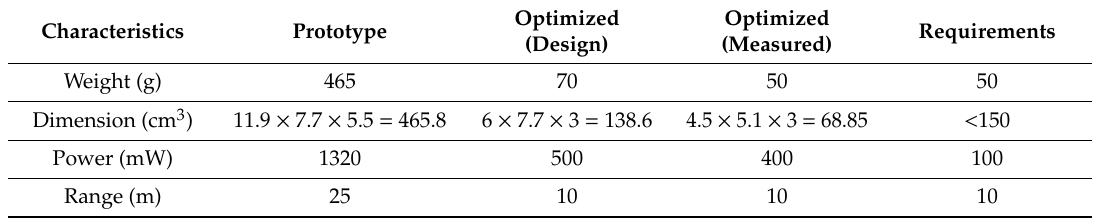
Table 4. Comparison between the prototype and the optimized module (long-range LiDAR).